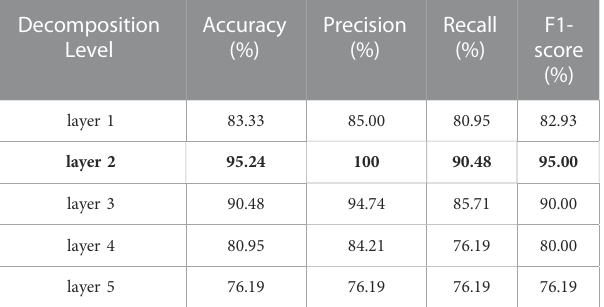
TABLE 3 Performance comparison of feature maps constructed by different layers of wavelet packet decomposition. Decomposition Level